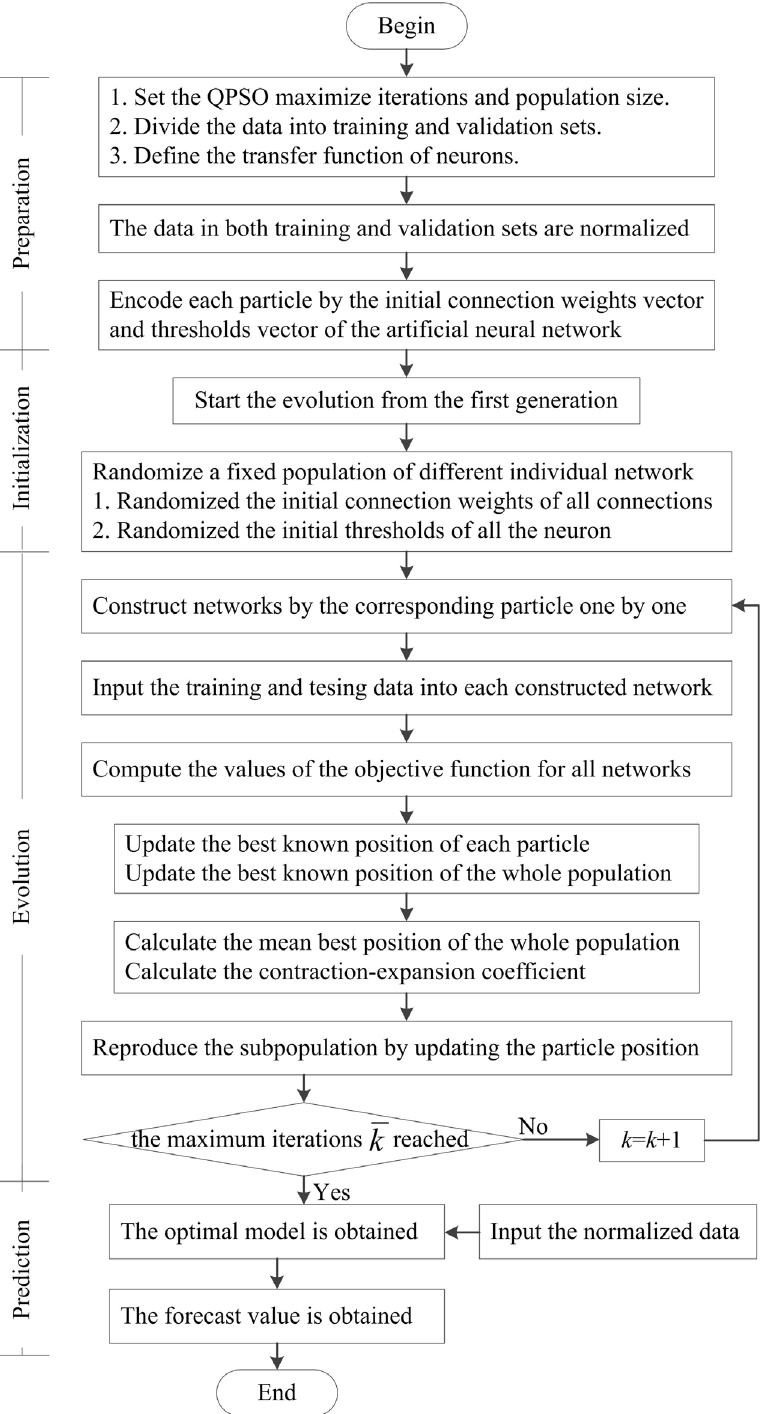
Figure 2. Flow chart of the proposed